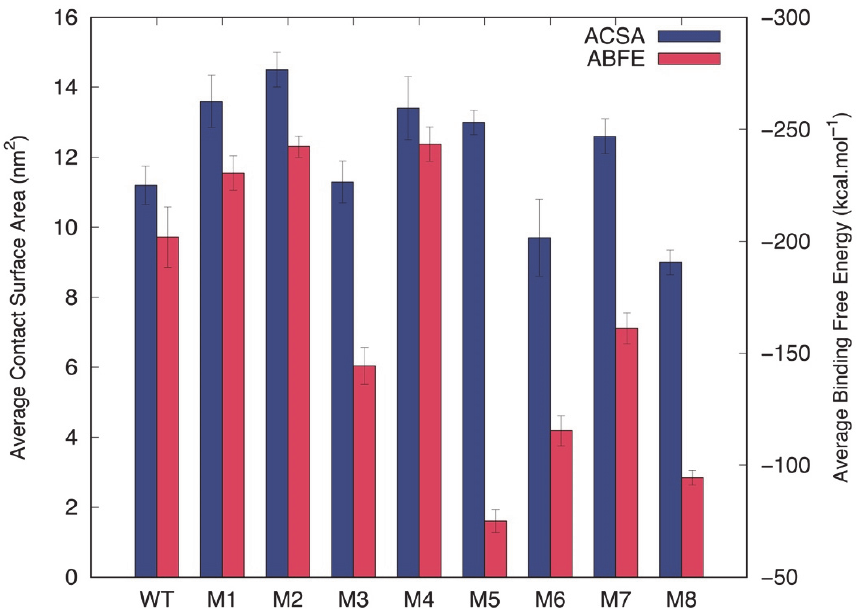
Figure 6. Average contact surface area (blue boxes) and average binding free energy (red boxes) between the wt:p10 and the evaluated mutants with the dsDNA.